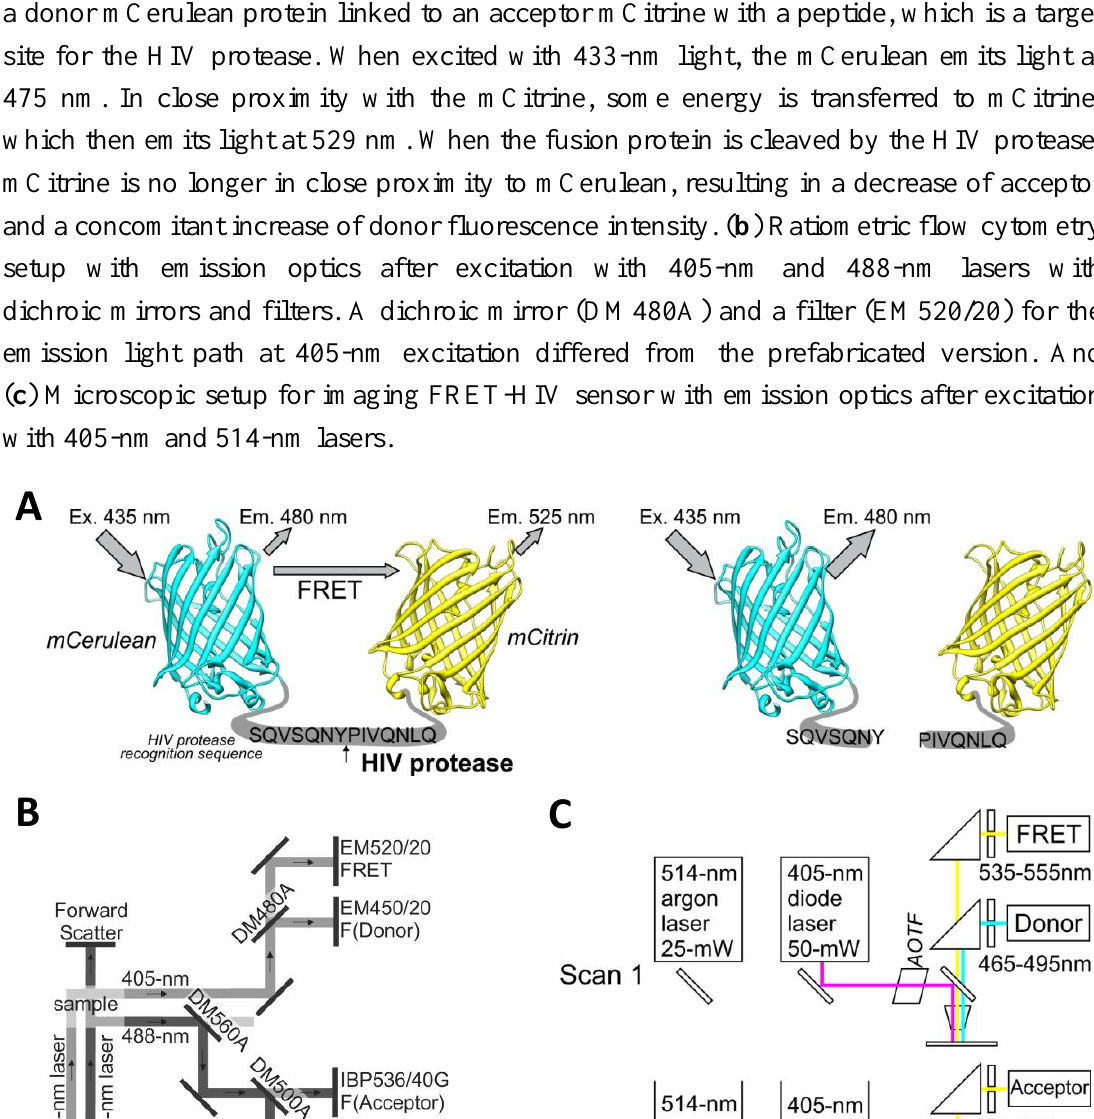
Figure 1. FRET-HIV protease-sensitive sensor. ( a ) The FRET-HIV sensor is composed of a donor mCerulean protein linked to an acceptor mCitrine with a peptide, which is a